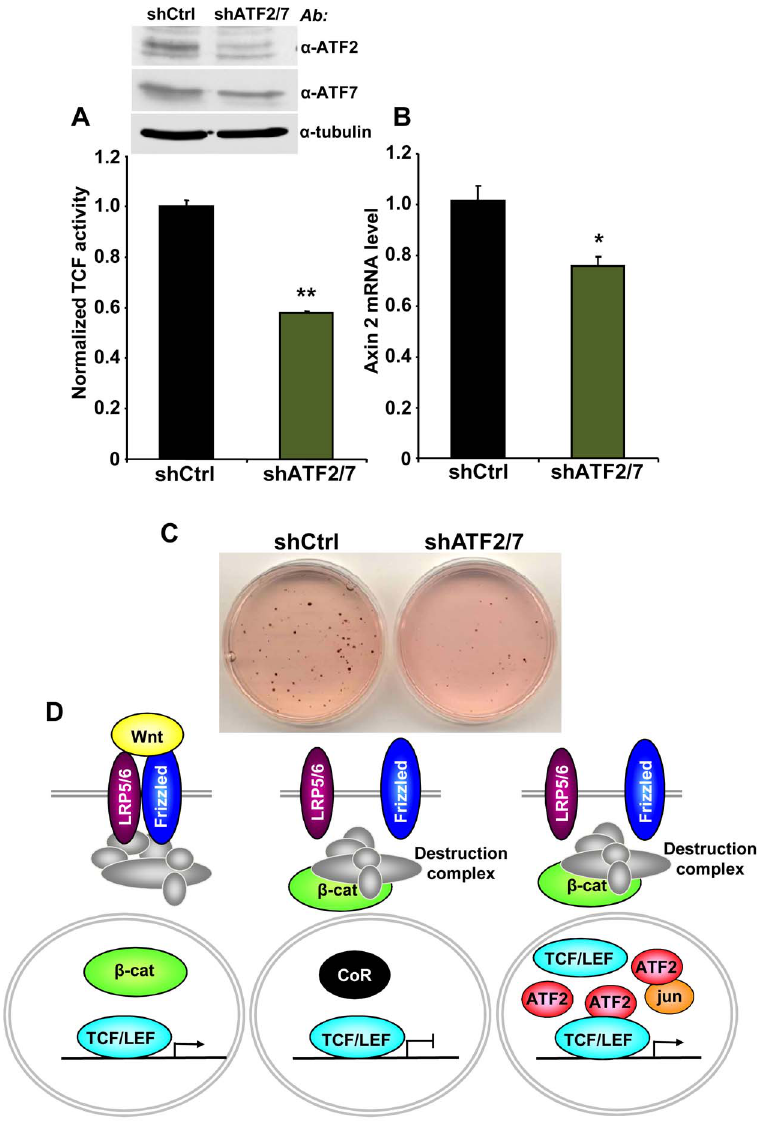
Figure 6. ATF2 and ATF7 knockdown in Ramos cells decreases TCF/LEF activity, Axin 2 expression and cell growth. (A–C) Ramos cells containing the TCF/LEF firefly and renilla luciferase lentiviral reporters were transduced with shATF2 and shATF7 or control lentiviral vectors. ATF2 and ATF7 down-regulation assessed by immunoblot analysis. (A) shATF2/7 inhibits constitutive TCF/LEF reporter activity in Ramos cells. (B) Knockdown of ATF2 and ATF7 reduces the expression of the Wnt target gene Axin 2 in Ramos cells as measured by quantitative real-time PCR. The results normalized to the control represent the mean values 6 SEM of three independent experiments. (*) P , 0.05; (**) P , 0.001 compared with control (two-way Anova test) (C) shATF2/7 inhibits Ramos cell colony formation. (D) Model for b -catenin-dependent and b -catenin-independent canonical Wnt signaling. See the text for details.